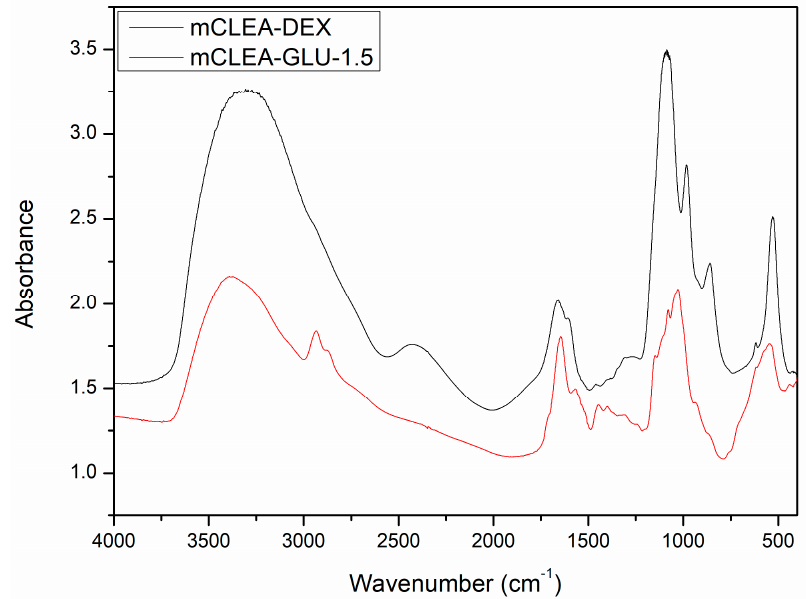
Figure 7. Fourier transform infrared (FTIR) spectra for mCLEA-DEX and mCLEA-GLU-1.5.